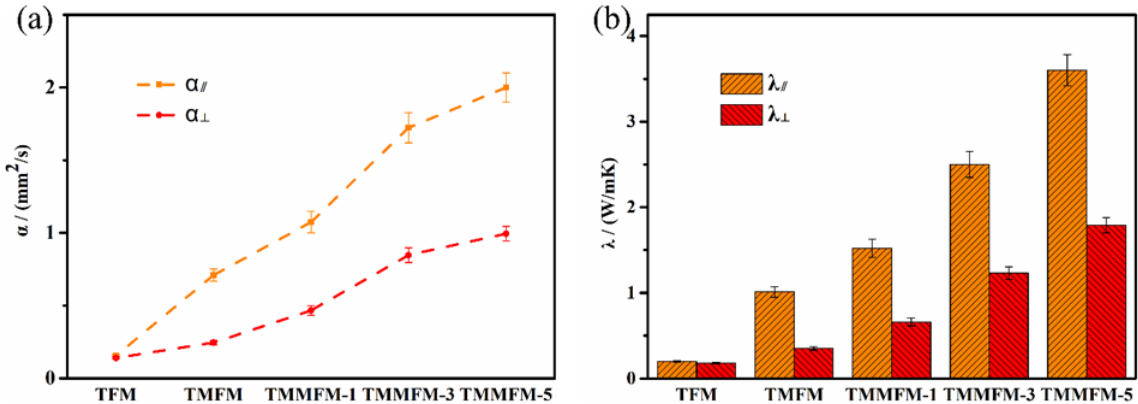
Figure 6. ( a ) α ⊥ and α ∥ values of TFM, TMFM and TMMFM. ( b ) λ ⊥ and λ ∥ values of TFM, TMFM and TMMFM.